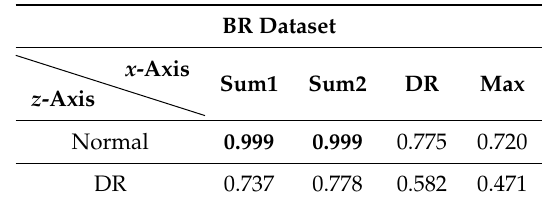
Table 5. MeanCos performance of eight different combinations on BR Dataset.